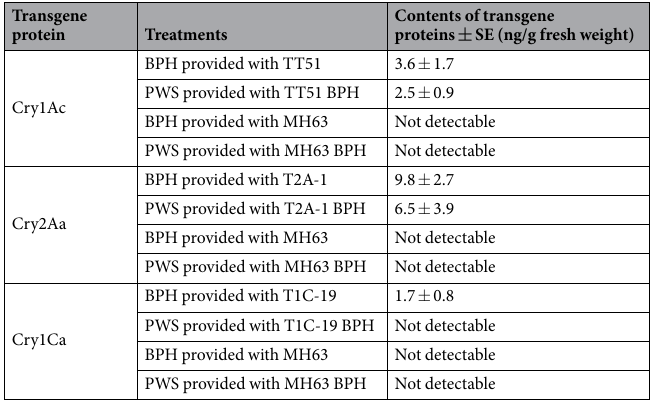
Table 1. Detection of Cry1Ac, Cry2Aa and Cry1Ca proteins in BPH after feeding on Bt rice and and PWS after predating on the